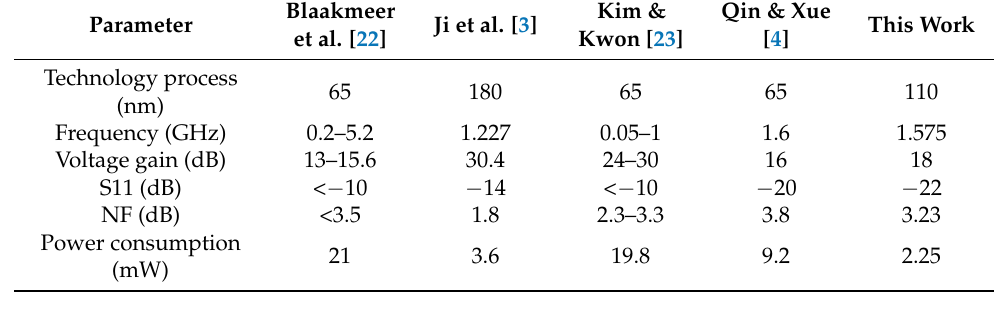
Table 1. Comparison of results for baluns from the literature.